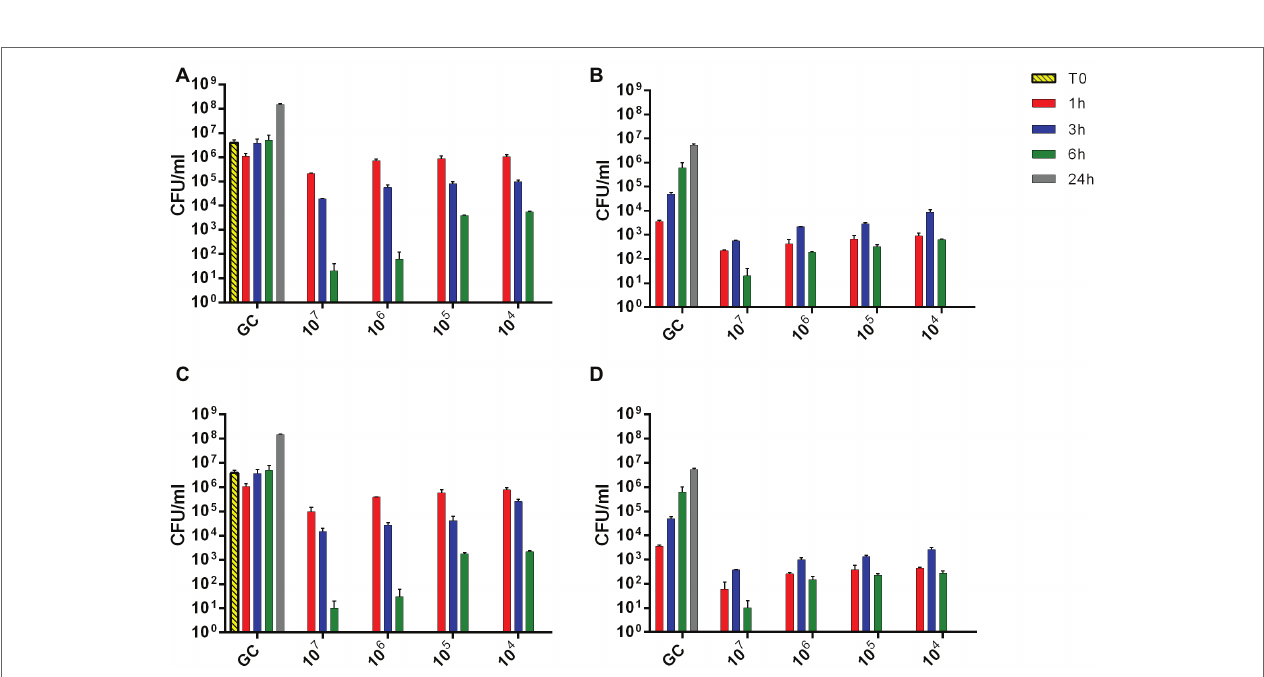
FIGURE 10 | The evaluation of viable bacteria attached on the beads (B,D) or free-swimming bacteria (A,C) in the supernatant. Histogram represents the mean of CFU number ± SEM of biofilm MRSA treated/untreated with different titer of Sb (A,B) and PYO (C,D) phages (ranging from 10 4 –10 7 PFU/ml). GC, growth